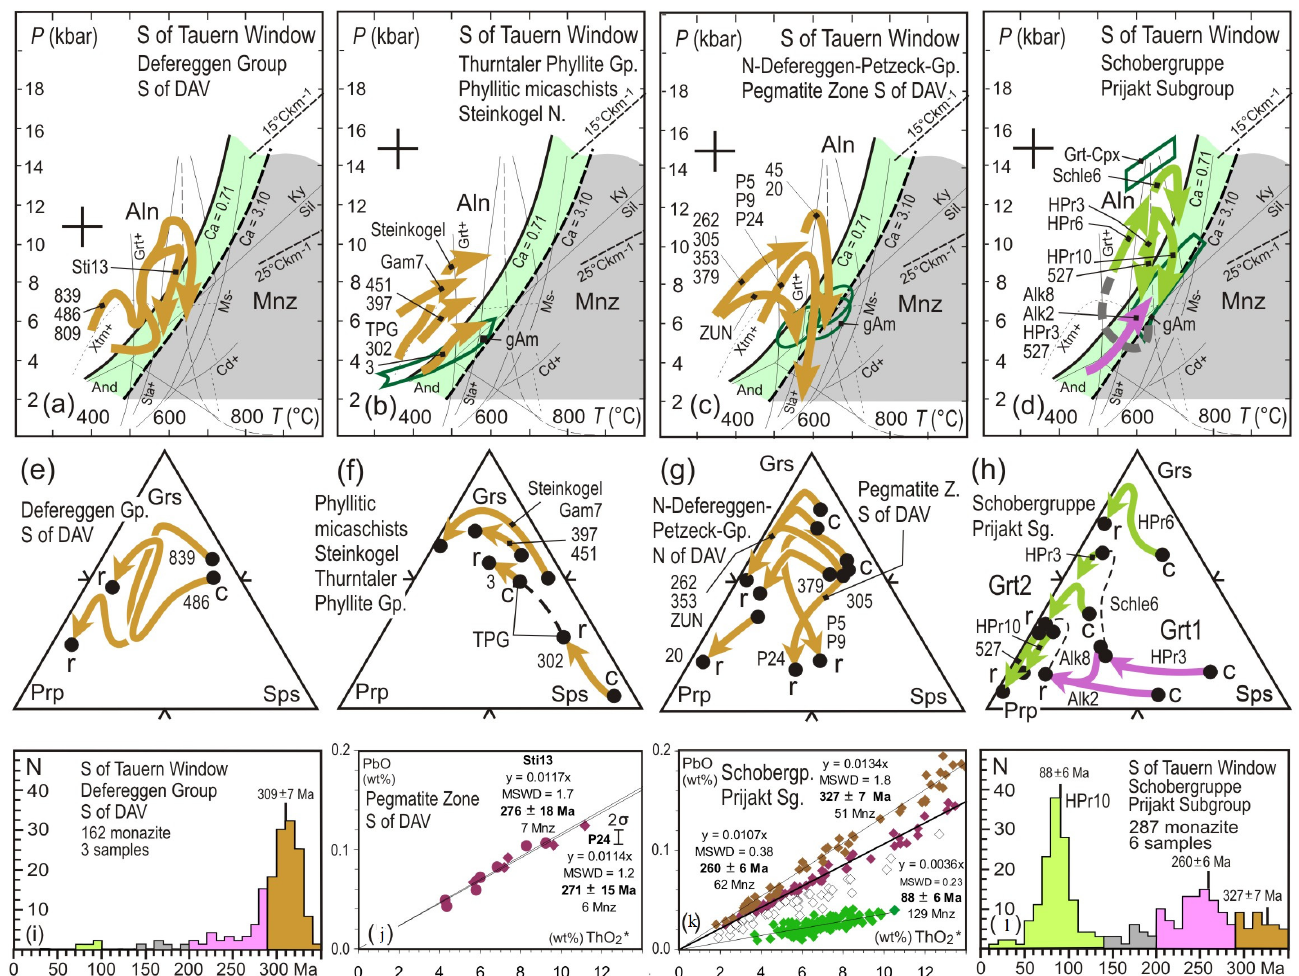
Figure 5. P-T paths, garnet zonations and EPMA Th-U-Pb monazite ages in various parts of the basement south of the Tauern Window in the Austroalpine Domain. Gp.: Group; Sg.: Subgroup; Z.: Zone. ( a – d ) P-T paths by microstructurally controlled geothermobarometry from garnet core-to-rim zonations in micaschists and paragneisses [16,61–63]. Aluminosilicates (and Ky, Sill), cordierite-in (Cd+), muscovite-out (Ms-) and staurolite-in and -out (Sta+, Sta-) univariant lines [30]. Stability fields (green and gray) of monazite (Mnz) and allanite (Aln) at different bulk rock contents as a function of Ca wt%, and with the xenotime (Xtm) stability field. Bold cross was uncertainty of ±50 °C/±1.0 kbar on P-T estimates. Geothermobarometric data from amphibolitised eclogite with garnet-clinopyroxene (Grt-Cpx) and from amphibolites with green amphibole endmember (gAm) equilibria. ( e – h ) Grossular-pyrope-spessartine (Grs-Prp-Sps) ternary diagrams of garnet core-to-rim (c,r) zonations, related to P-T paths in ( a – d ). ( i ) Histogram of monazite ages in the Defereggen Group to the South of the Defereggen-Antholz-Vals Line (DAV). ( j , k ) ThO 2 *-PbO (wt%) isochrone diagrams. Data from zone with pegmatites immediate to the south of the DAV line and from the Prijakt Subgroup of the Schobergruppe. The col- oured symbols mark analyses belonging to monazite age populations and defining isochrones, falling into Carboniferous (brown), Permian (violet) and Cretaceous (green) ranges of ages. ( l ) Histogram of monazite ages in the Prijakt Subgroup of the Schobergruppe.